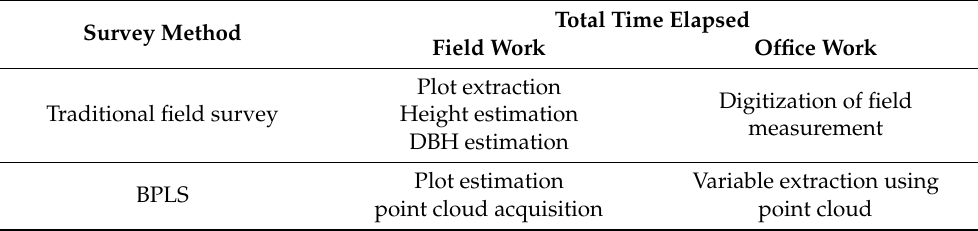
Table 4. Survey methods categorized by